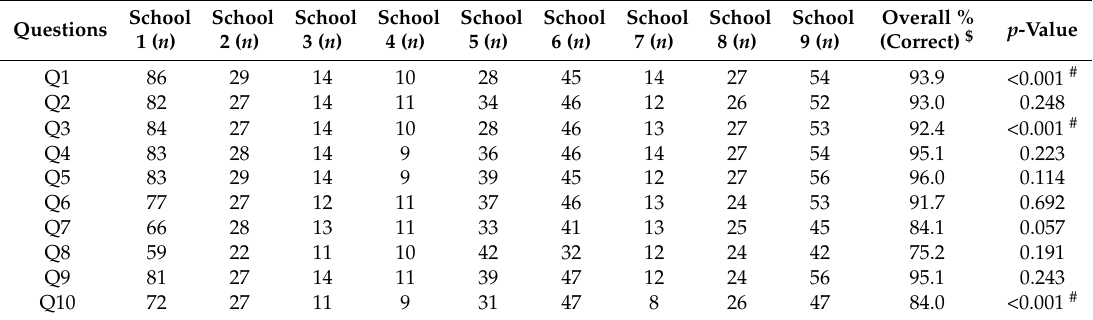
Table 3. Frequency of correct answers school-wise and overall post-test percentage response of participating